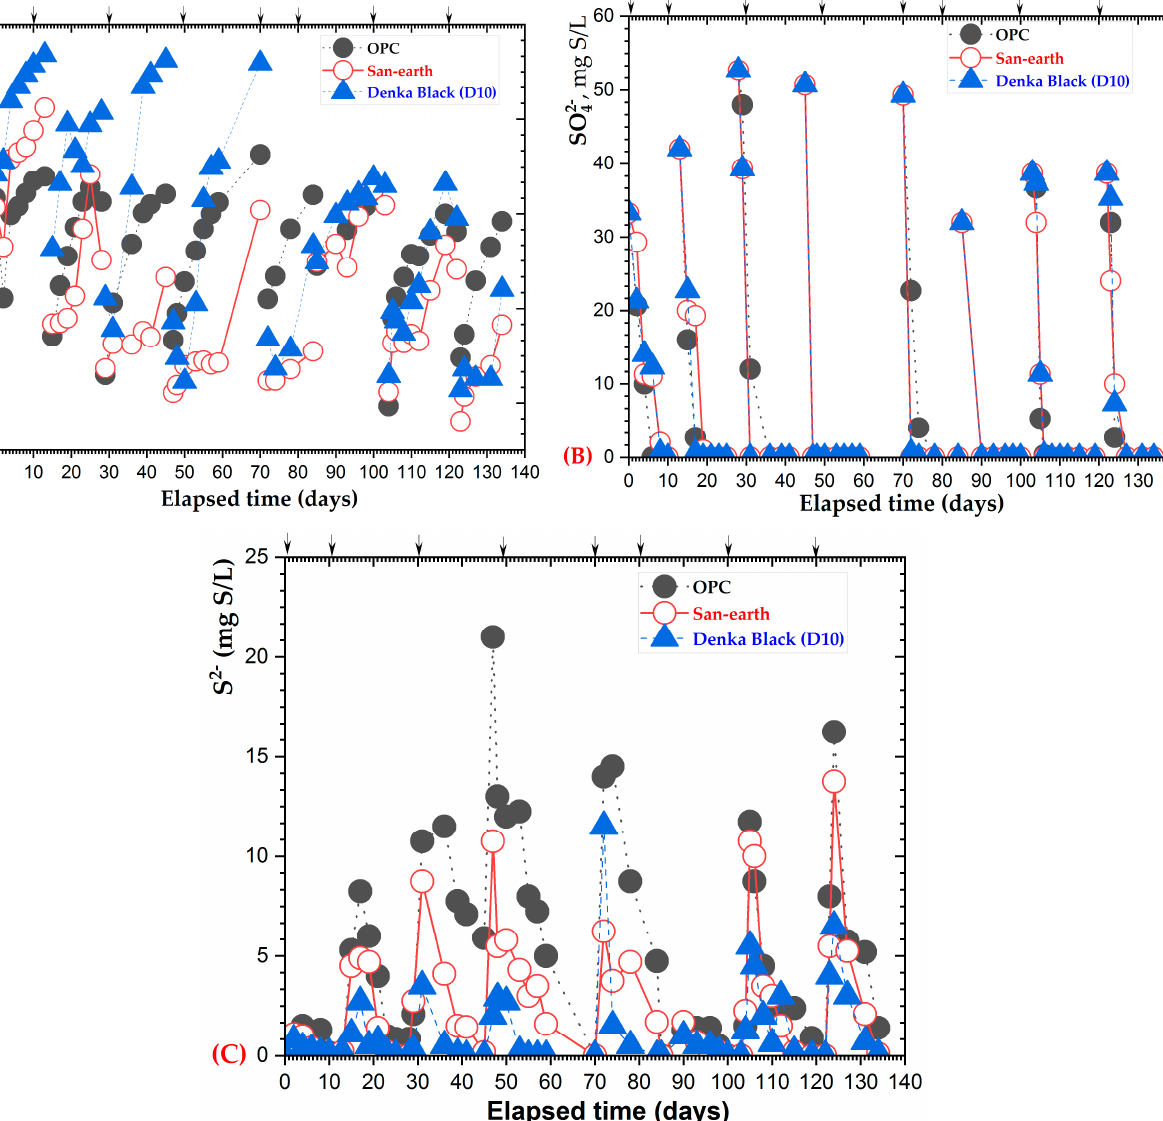
Figure 8. Sulfide reduction experiments using concrete: OPC, San-earth, and Denka Black. The arrows indicate the addition of glucose and magnesium sulfate. ( A ) pH, ( B ) sulfate, and ( C ) sulfide concentrations. Arrow ( ↓ ) indicates the addition of glucose and magnesium sulfate.